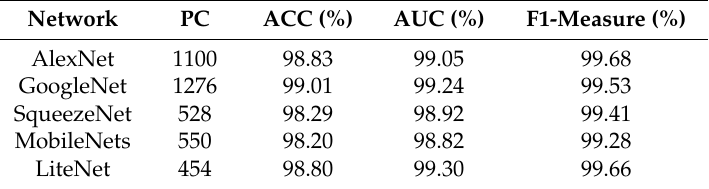
Table 7. Comparison of four CNN-based networks for set B with the ten-fold cross-validation method.